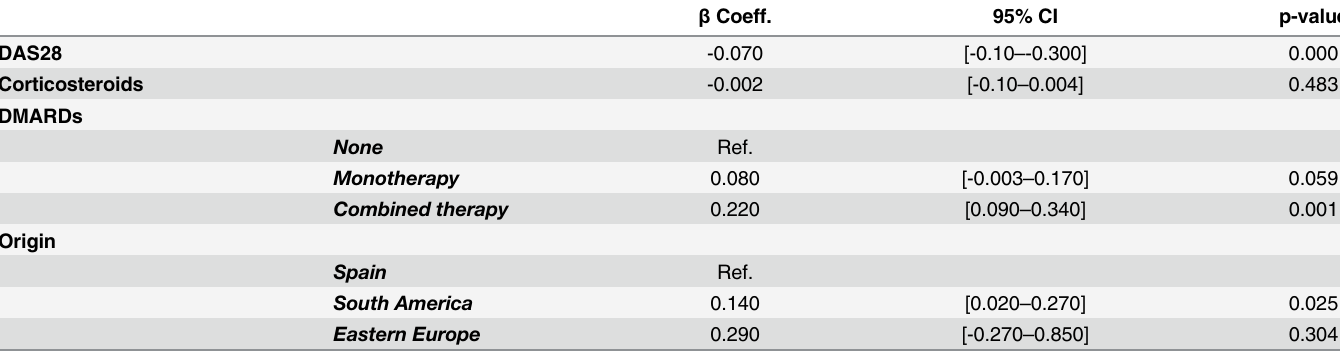
Table 2. Multivariate analysis of variables associated with VPAC1 expression during follow-up of patients with early arthritis.